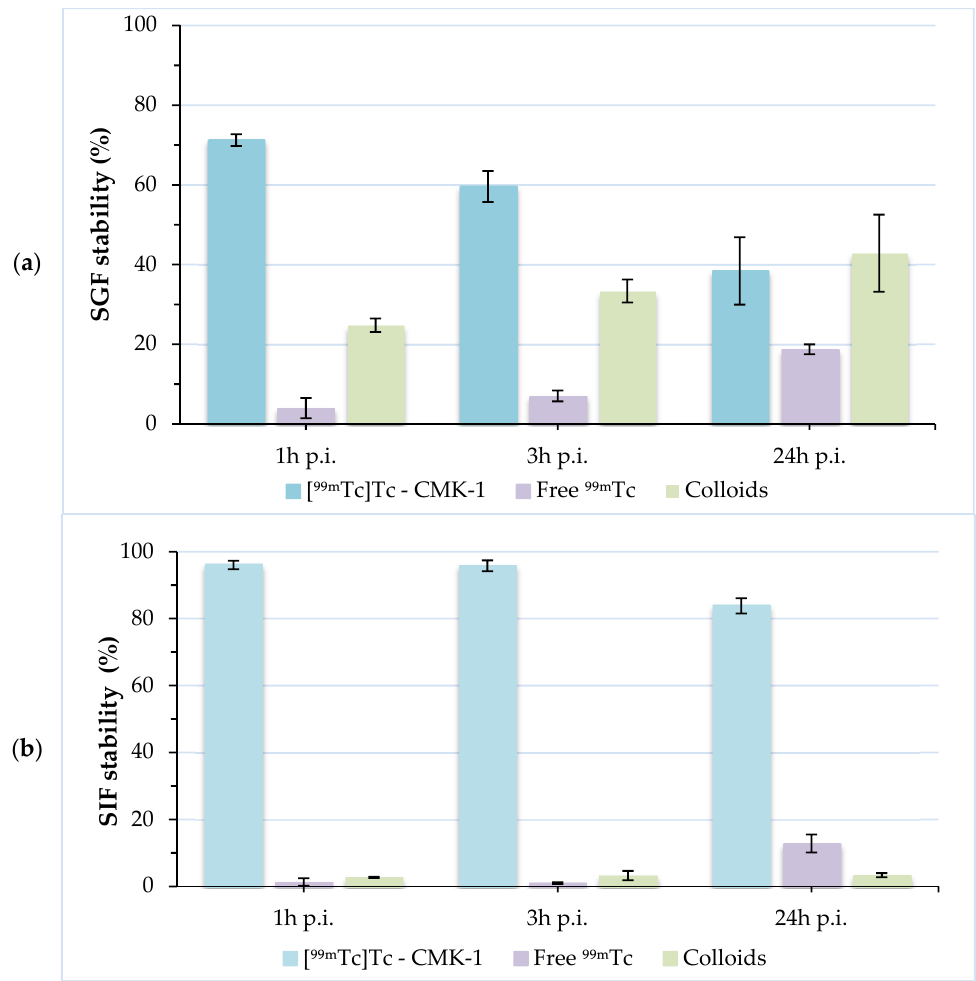
Figure 5. Radiochemical stability of [ 99m Tc]Tc-CMK-1 in the presence of: ( a ) simulated gastric fluid and ( b ) simulated intestinal fluid at 1, 3 and 24 h post-incubation (p.i.).